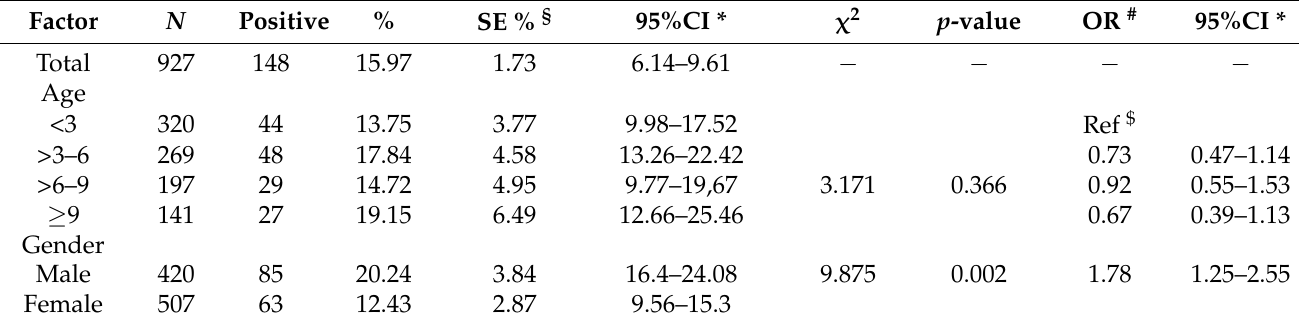
Table 3. Seroprevalence of infection with Ehrlichia spp. and risk factor analysis by age and gender in stray dogs in the Campania Region in 2016–2019 as detected by qualitative dot-ELISA SNAP 4DX ® (IDEXX Laboratories).